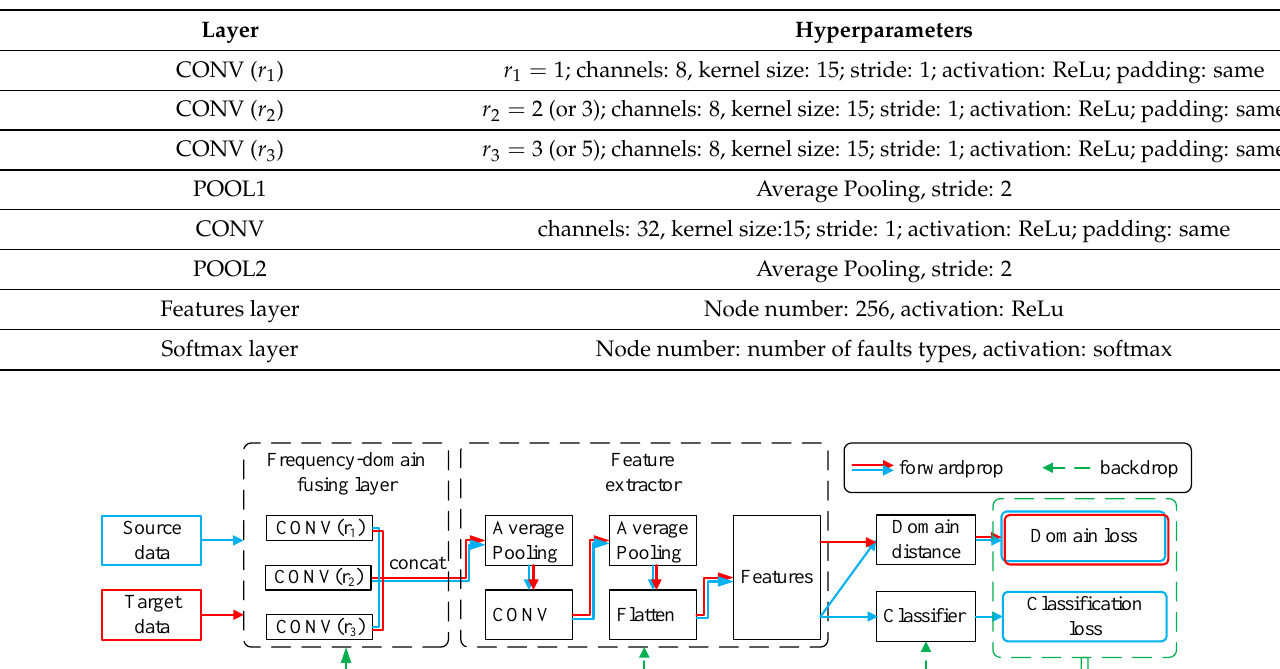
Table 1. Details of proposed Frequency-domain Fusing Convolutional Neural Network (FFCNN) architecture.